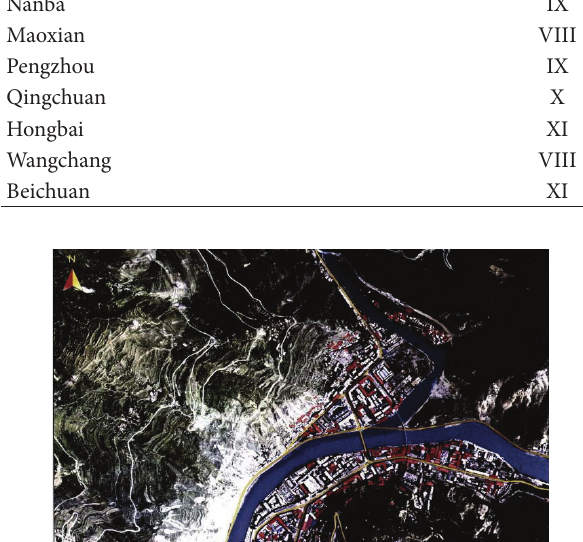
Figure 4: (a) Fifteen points labeled in remotely sensed satellite image; (b) isoseismal line based on the fifteen discrete evaluation